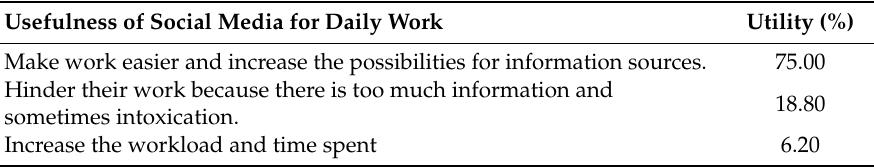
Table 5. Usefulness of social media for daily work.